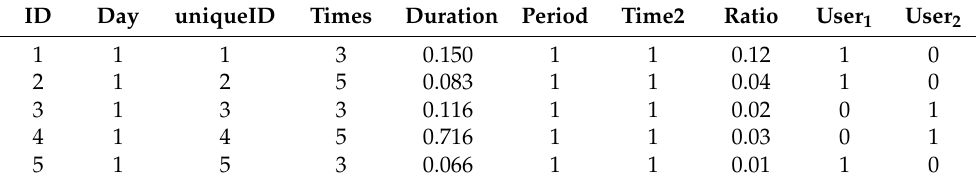
Table 9. Examples of the filtered activity